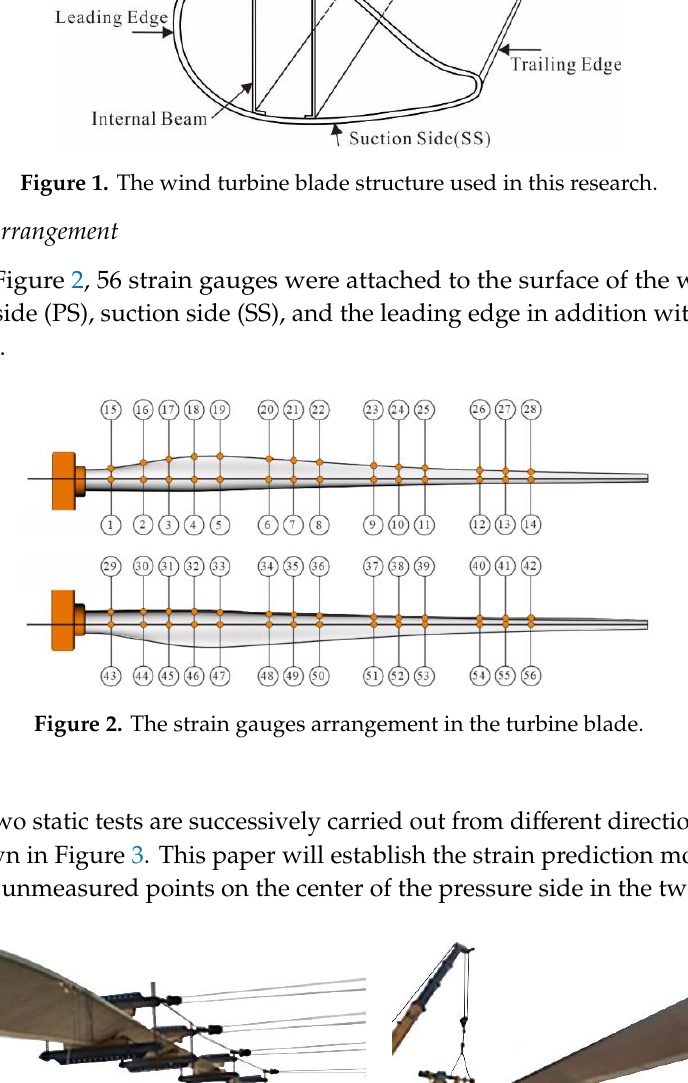
Table 1. The main information of the turbine blade.